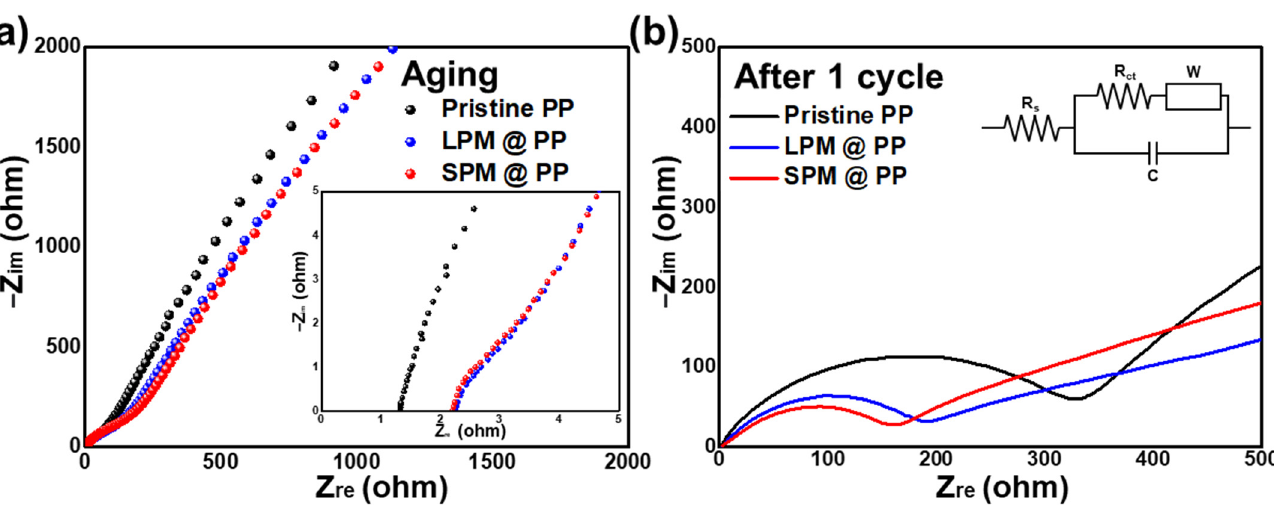
Figure 5. Electrochemical impedance spectra (EIS) of Li-Cu cells with pristine PP separator, and the LPM- and SPM-coated separators ( a ) before and ( b ) after one cycle.